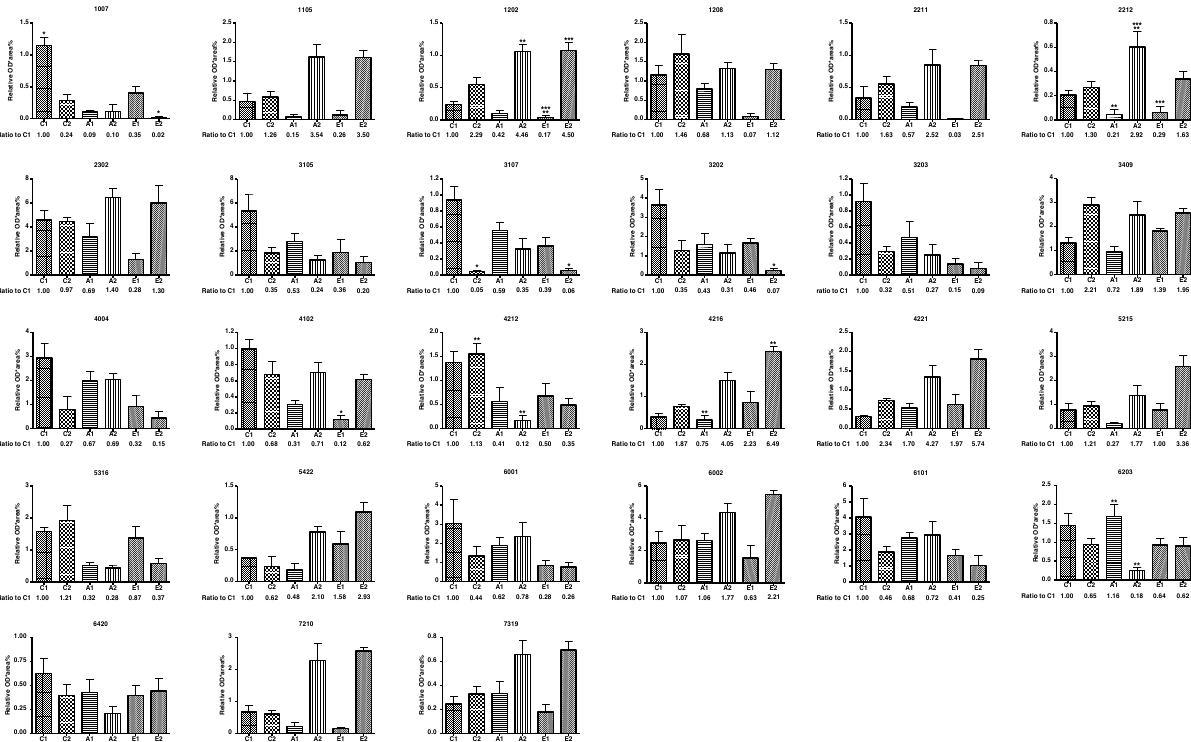
Figure 4. Quantification of differentially expressed proteins extracted from asymptomatic (C1, A1, E1) and black streaked (C2, A2, E2) trunk wood of control (C1, C2), apoplectic (A1, A2) and esca proper affected (E1, E2) grapevines. Vertical axis represents the relative value of optical density × area (relative OD × area %) of the total value observed in the gel images as a measure of expression. Histograms indicate the mean quantitative values (± standard deviation: SD) of three independ - ent experiments. Relative mean values (± SD) are from three relative values obtained by dividing the value of each spot to the total density of the corresponding gel. Differences among the means were evaluated by the Dunn’s Multiple Compari - son Test, and after that the null hypothesis (equal means) was rejected in the Kruskal-Wallis test, assuming a significance of P ≤0.05. One asterisk indicates a statistically significant difference with the control C1. Two or three asterisks indicate statistically significant differences between the two classes where they were added. The relative expression ratio to C1 in the other groups is